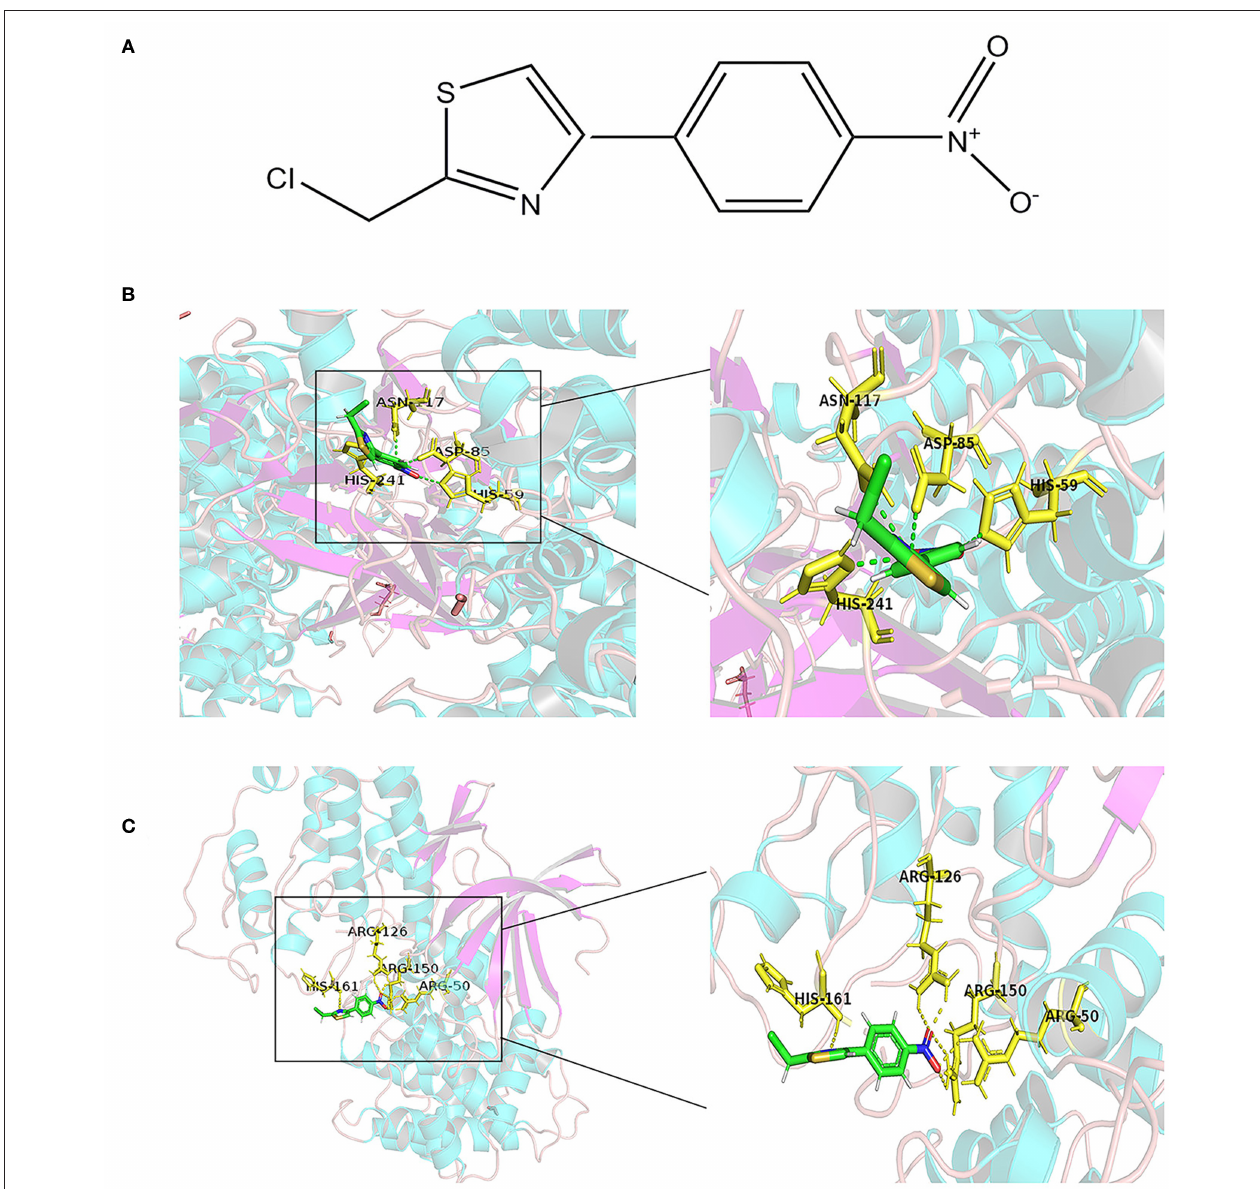
FIGURE 6 | Docking combination of APS and key proteins. (A) Chemical structure of APS: 2-(Chloromethyl)-4-(4-nitrophenyl)-1,3-thiazole. The green structure is the Astragalus polysaccharide, and the yellow structure represents the binding site of CDC6 (B) and CCNB1 (C)